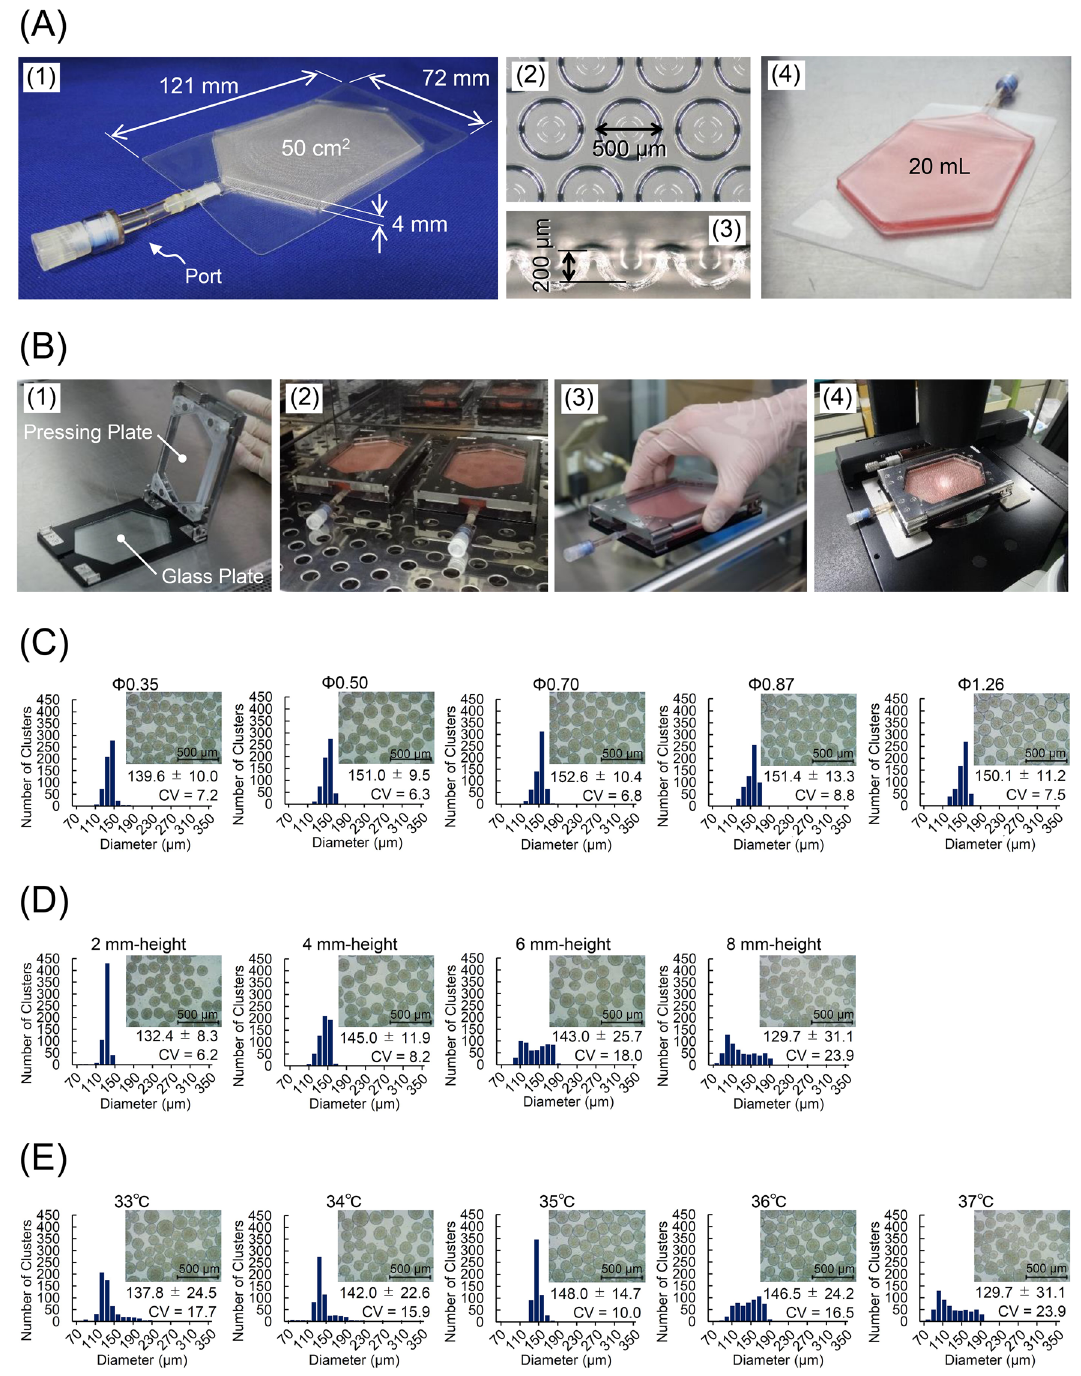
Figure 1. Optimization of microwell bag culture. ( A ) The design of a small-scale microwell bag. (A-1) The appearance of the small- scale microwell bag. The bag was made of a gas-permeable film and connected with a port. (A-2) Overhead view of microwells with the top film removed. (A-3) A cross-section image of microwells. (A-4) The appearance of the microwell bag containing 20 mL culture medium. ( B ) The design of a jig for a small-scale microwell bag. (B-1) The appearance of the jig with an open cover. A glass plate is inserted in the base plate, and a transparent pressing plate is attached to the cover. (B-2) Cells were cultured with the bag attached to the jig in an incubator. Displacement of the jig–bag assembly (B-3) and cell observation under a microscope (B-4) were performed in a manner similar to that for general cell culture vessels. ( C – E ) Distribution of cluster size after 2 day culture of human induced pluripotent stem cells (hiPSCs) in a small-scale bag. The size of the clusters was analyzed from their phase-contrast images. In total, 600 clusters were used for the measurement (data represent mean ± standard deviation), and coefficients of variation (CVs) are indicated in the histogram. The inserted photographs are representative phase-contrast images of the clusters harvested from the bags. ( C ) hiPSCs were cultured in the bags with φ 0.35 mm, φ 0.50 mm, φ 0.87 mm, and φ 1.26 mm microwells. ( D ) hiPSCs were cultured in the bag with φ 0.50 mm microwells, and heights of 2, 4, 6, and 8 mm. ( E ) hiPSCs were seeded into an 8 mm-height bag with φ 0.50 mm microwells, following suspension in the medium at 33, 34, 35, 36, or 37 °C; cells in the bag were mixed on a hot plate set to the same temperature. The result at 37 °C corresponds to 8 mm height in (D). Scale bars = 500